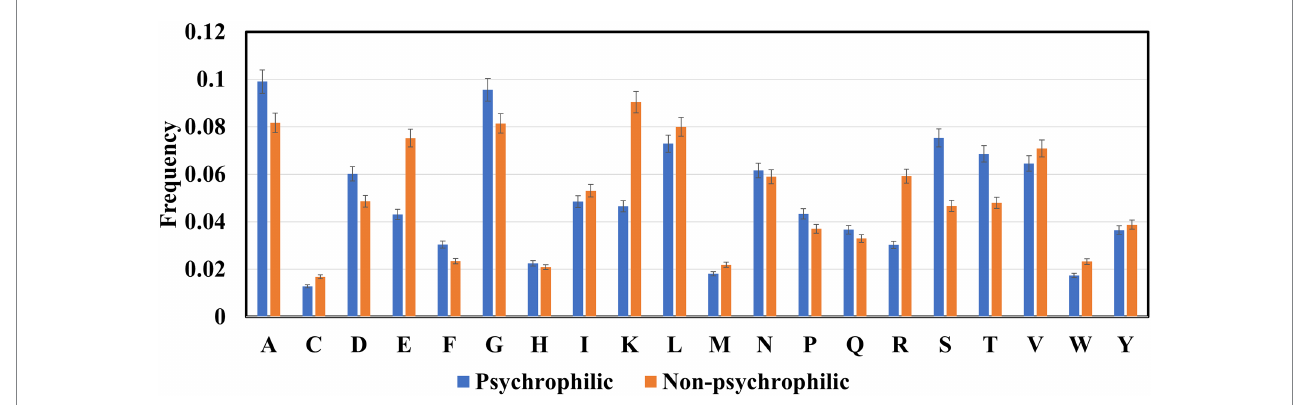
FIGURE 3 The amino acids composition in the psychrophilic and non-psychrophilic proteins.